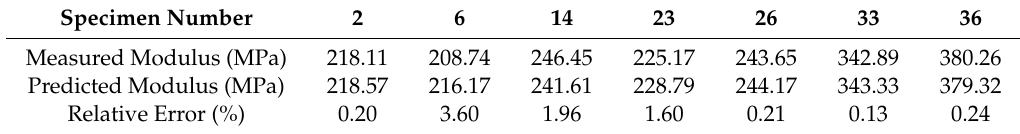
Table 2. Comparison of the experimental and DNN-predicted results of tensile modulus for test samples.